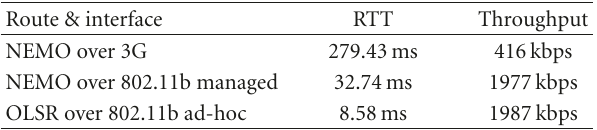
Table 3: Performance of the MANEMO system under static conditions and depending on the route